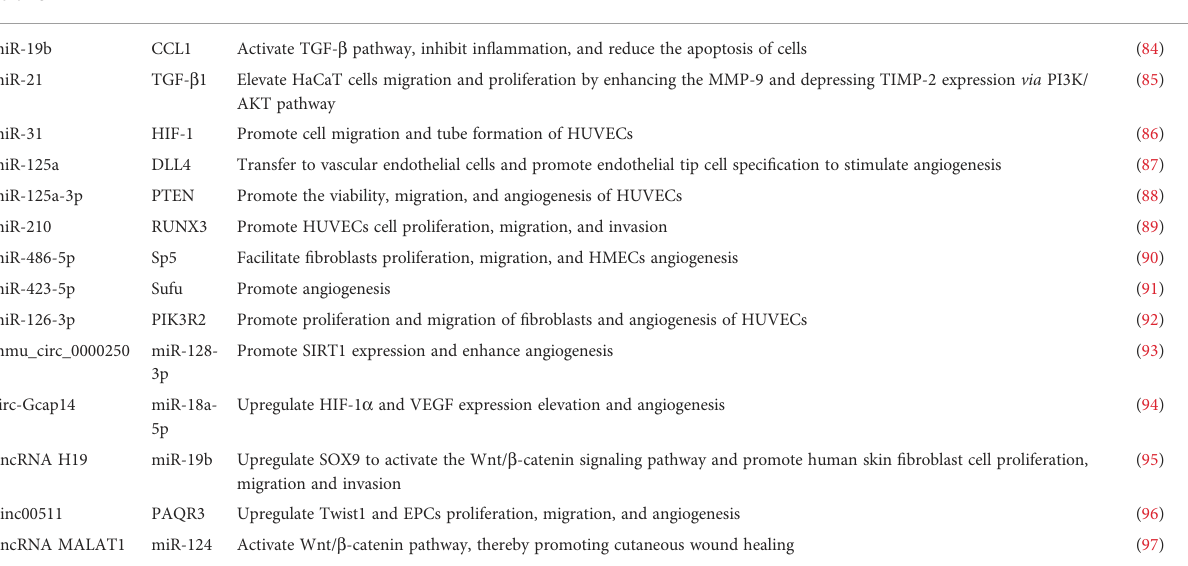
TABLE 1 The functions of ADSCs-derived EVs in diabetic foot ulcers. Non-coding Target RNAs